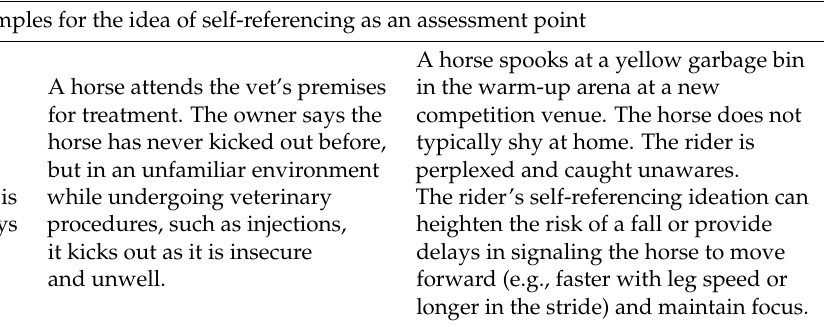
Table 4. Examples from track-work riders and jockeys, equine veterinarians and equestrian competitors that illustrate self-referencing as a cognitive error that increases the risk of injuries. Track-Work Riders